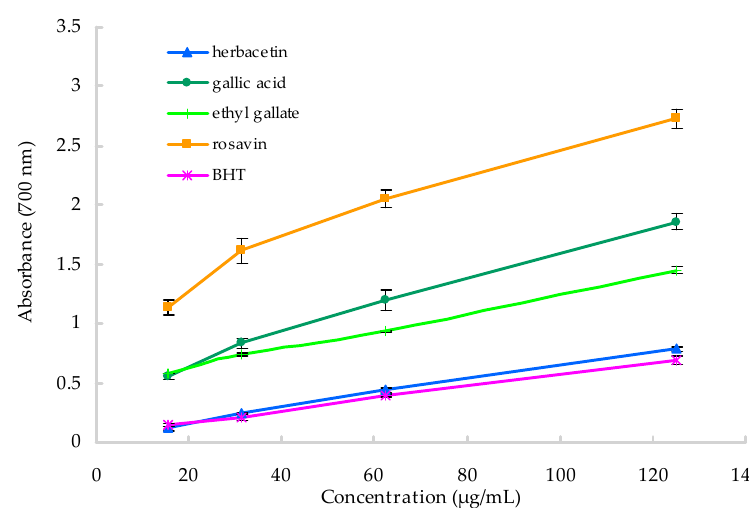
Figure 4. The reducing power of the four compounds of R. crenulata.